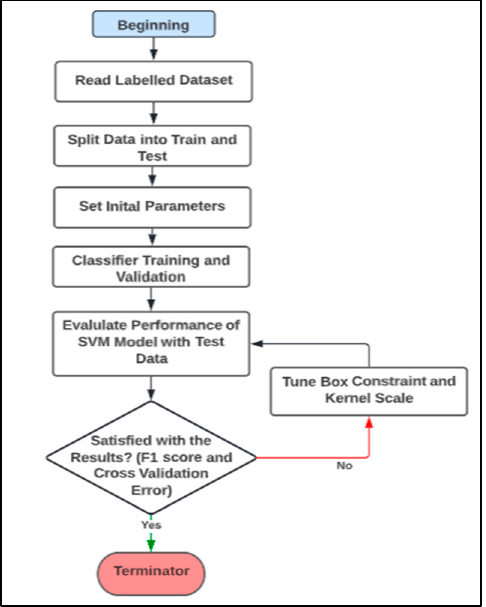
Figure 5. Workflow chart of the SVM algorithm for fault detection and identification.